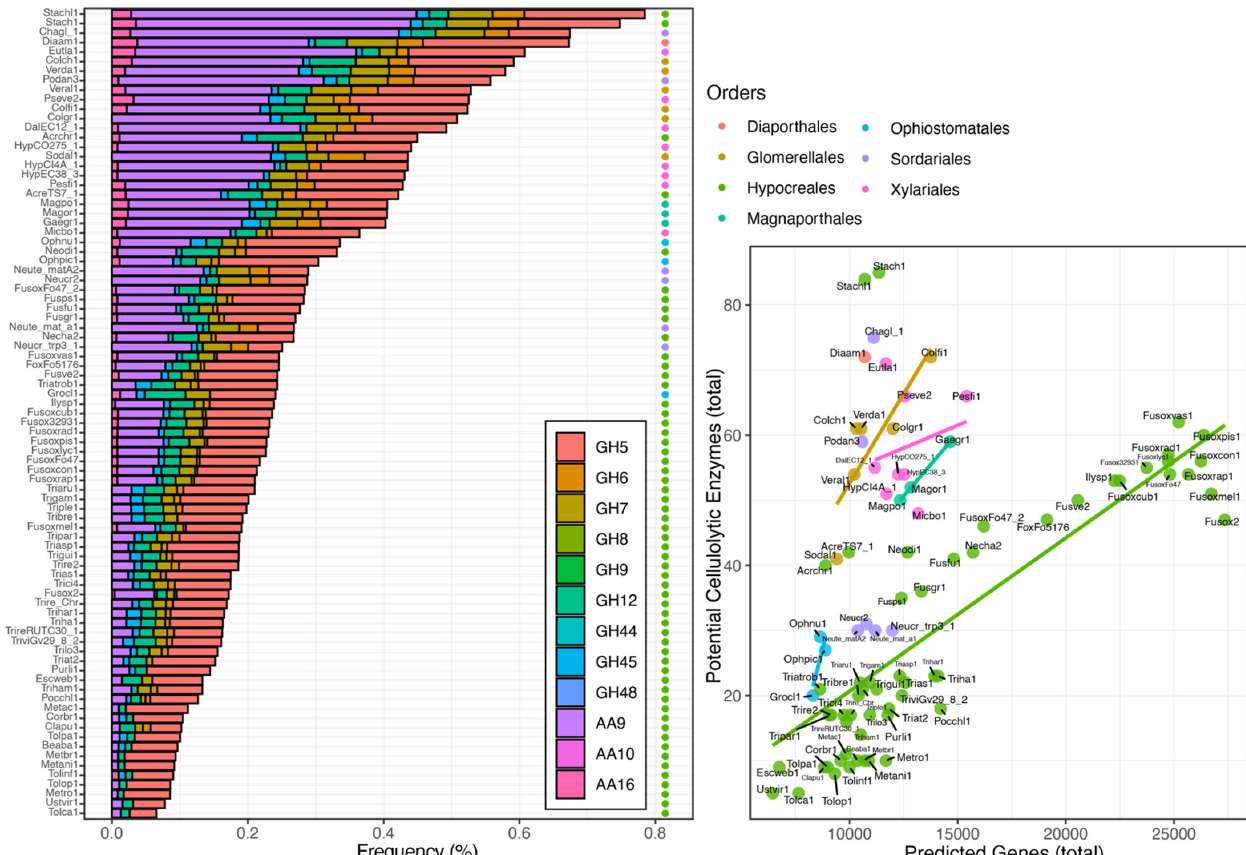
Figure 3. The functional potential for cellulose deconstruction in sequenced genomes from the class Sordariomycetes ( n = 85 genomes). Frequency of the predicted potential cellulases (left) and total number of predicted potential cellulases across orders of Sordariomycetes (right). Lines depict the linear regression between the predicted cellulases and the predicted number of genes, if correlated (i.e., P Pearson < 0.05).